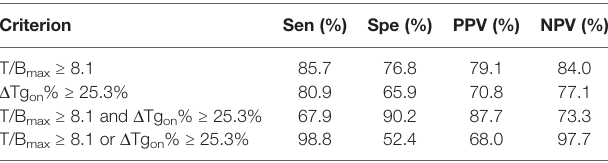
TABLE 3 | Ef fi cacy of T/B max of 8.1 and/or D Tg on % of 25.3% in predicting biochemical response to next radioiodine treatment.